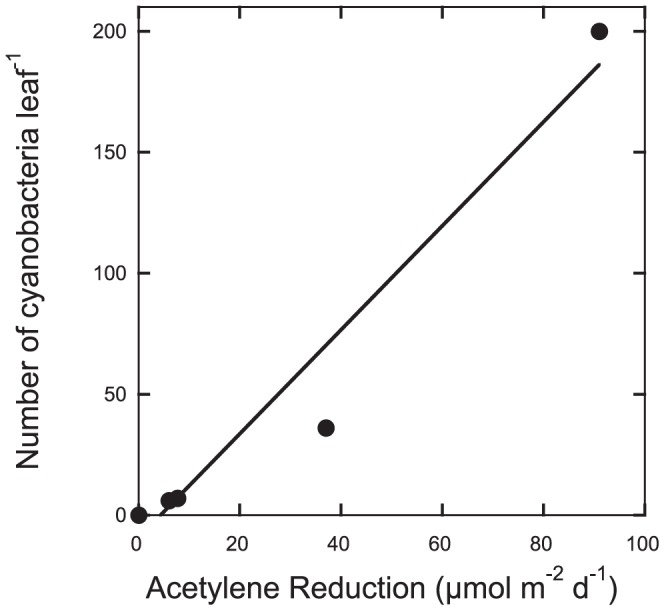
Numbers of cyanobacteria cells leaf−1 in relation to acetylene reduction (µmol m−2 d−1) in the feather moss P. schreberi.